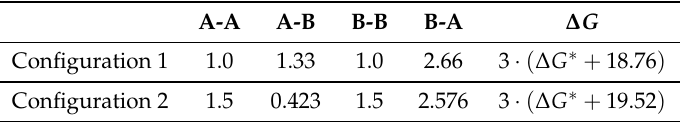
Table 1. Average bond breakage for each type of atom in the A-B Kossel crystal configurations and ∆ G and ∆ G ∗